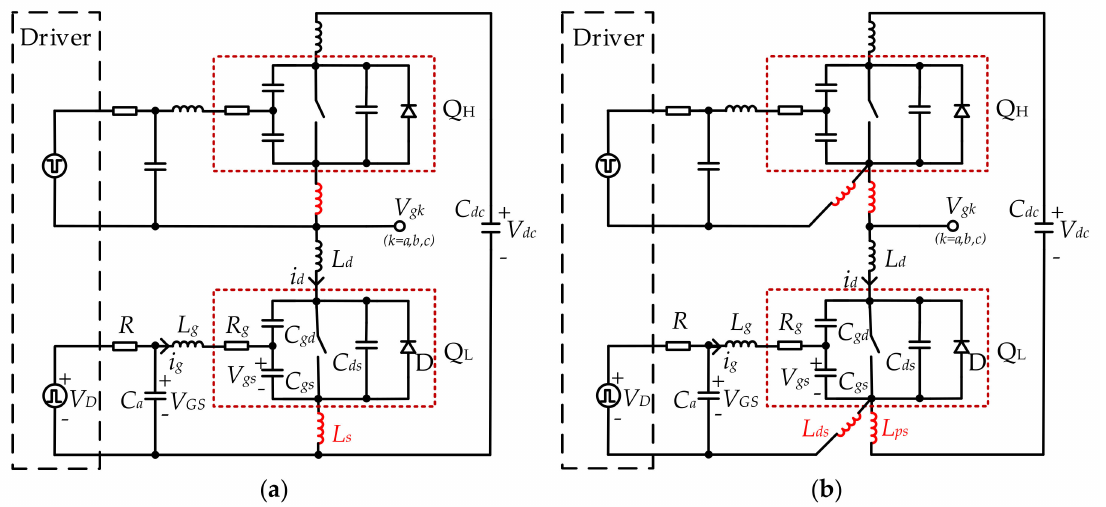
Figure 3. The parasitic parameters of the bridge circuit and its driving circuit: ( a ) 3-pin SiC Metal-Oxide-Semiconductor Field-E ff ect Transistor (MOSFET), ( b ) 4-pin SiC